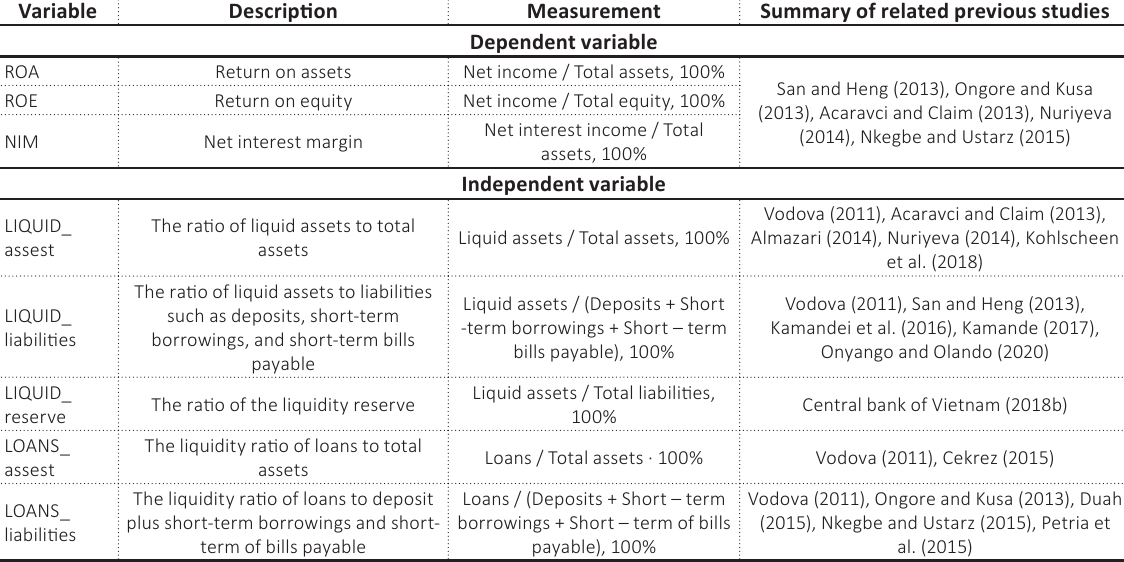
Table 1. Description of the variables used in the regression